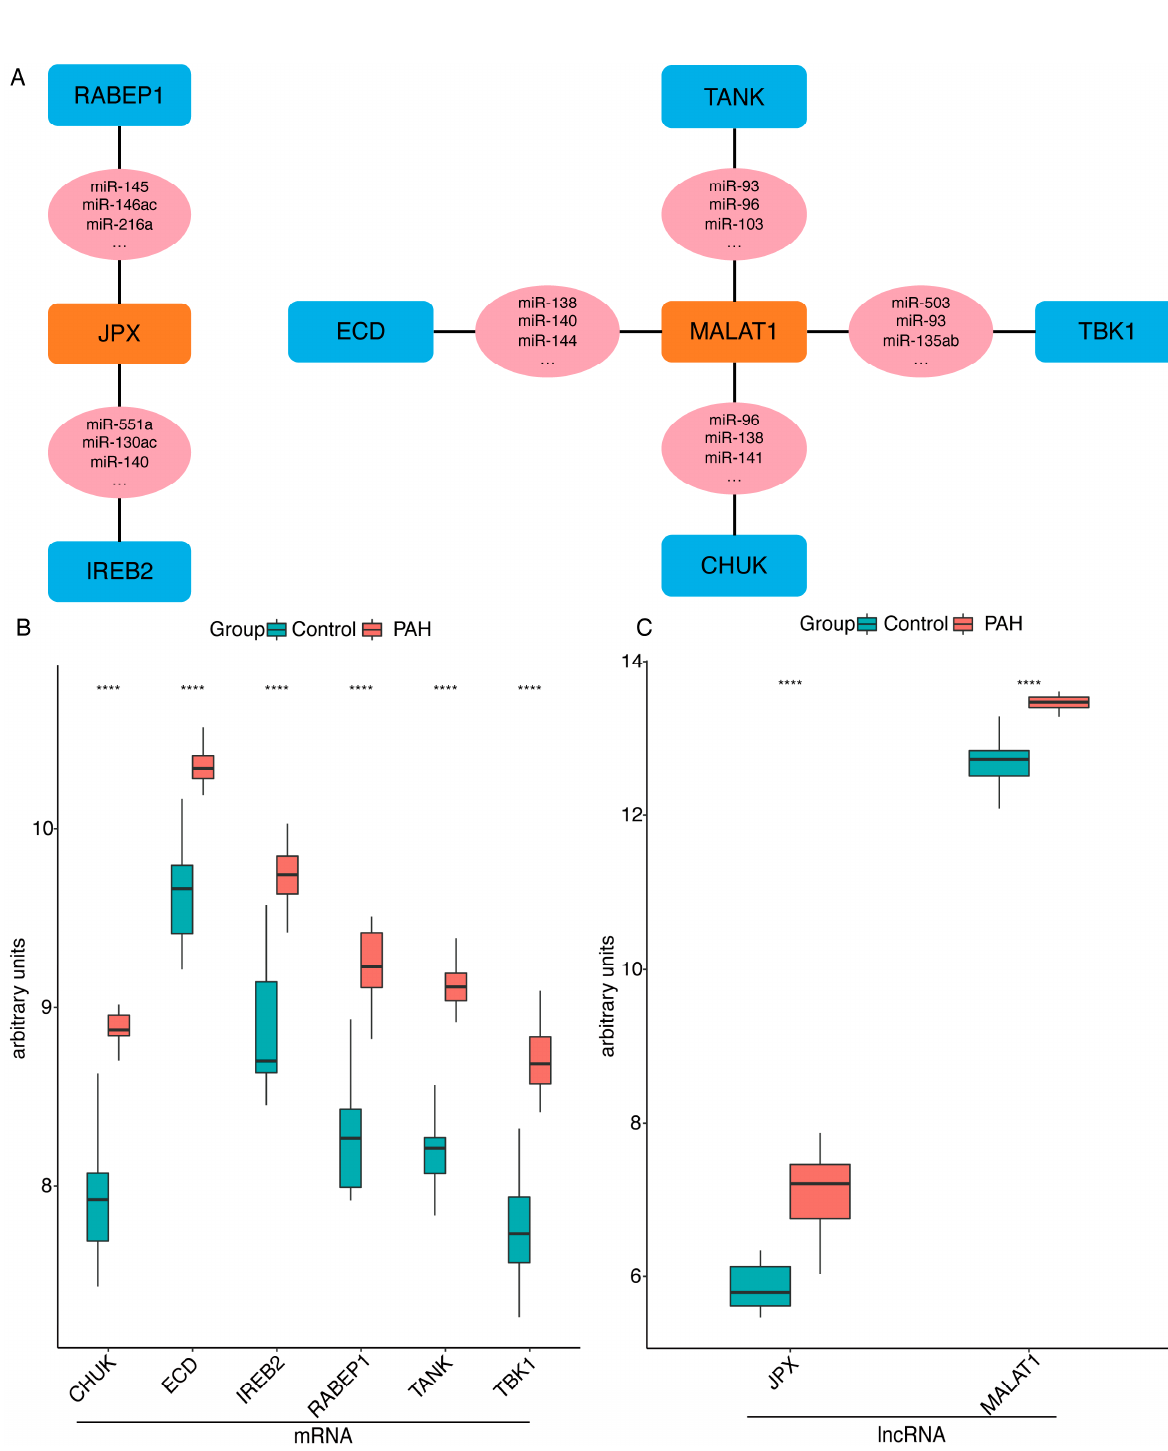
Figure 2. The immune-related ceRNA network and the expression of lncRNA-mRNA pairs in the training GSE113439 dataset. ( A ) The immune-related ceRNA network. The blue nodes represent mRNAs, the pink nodes represent miRNAs and the orange nodes show lncRNAs. The mRNAs and lncRNA are linked by a common miRNA with a black thread. ( B ) The expression of mRNAs included in ceRNA network among the PAH and control samples. ( C ) Expression of lncRNAs included in ceRNA network among the PAH and control samples. PAH, pulmonary arterial hypertension; **** p value <